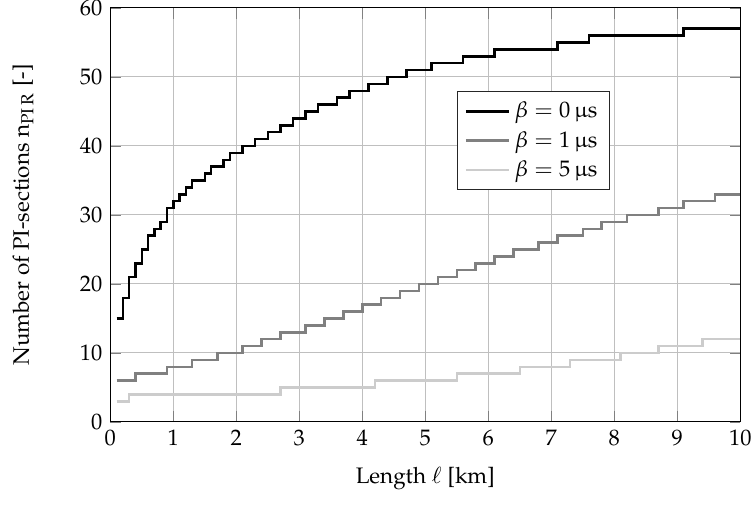
Figure 14. Number of PI-sections for different specified error in the time